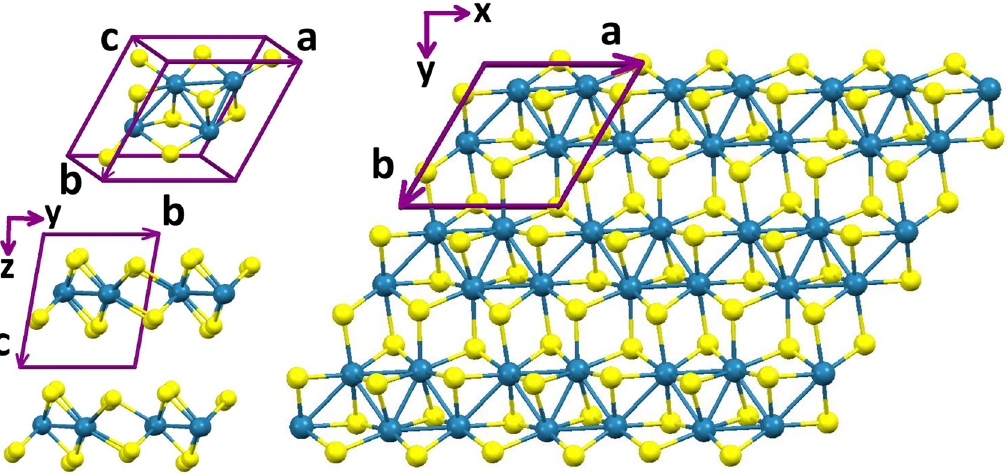
Figure 1: The unit cell, side and top views, of the ReX 2 bulk structure. The a, b, and c are crystallographic axes marking the unit cell. Rhenium andsulfur(orselenium)atomsare indicatedinblueandyellow,respectively.It canbeseenthattheset of theelementarycells formsa quasi – two-dimensional bulk material. The x, y, z, axes are marking the cartesian coordinates